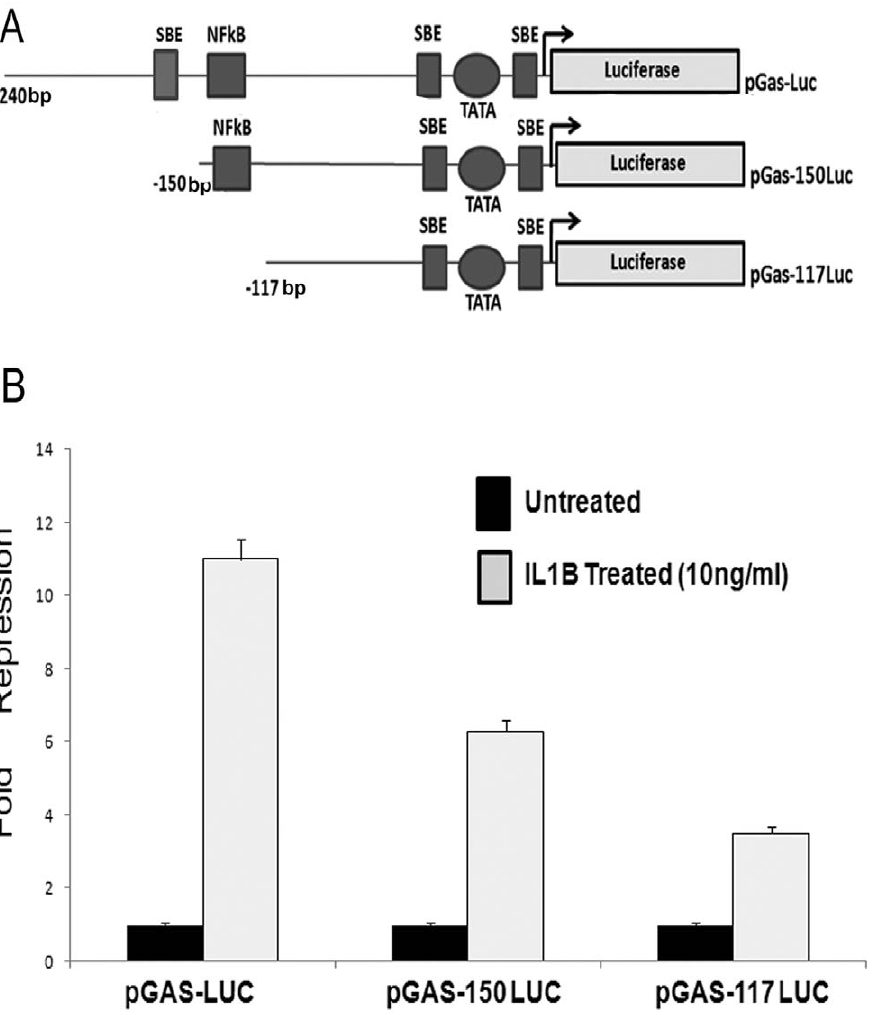
Figure 1. Deletion mapping of 240bp human gastrin promoter for IL1B responsive elements. (A) Schematic diagram of serial deletion of putative gastrin promoter cloned upstream of luciferase reporter gene. The boxes and circle represent different transcription factor binding sites within the 240 bp gastrin promoter. The line diagrams depict the different deletion clones used for the study. (B) The fold inhibition in luciferase activity of different deletion constructs of the gastrin promoter in AGS cells in presence and absence of recombinant IL1B (10 ng/ml). AGS cells were transfected with respective gastrin promoter deletion constructs. Forty-six hours after transfection, cells were either treated or left untreated with 10 ng/ml of IL1B for two hours and then harvested. Luciferase activity was measured and the average fold differences between the treated and untreated sets were plotted from three different experiments.